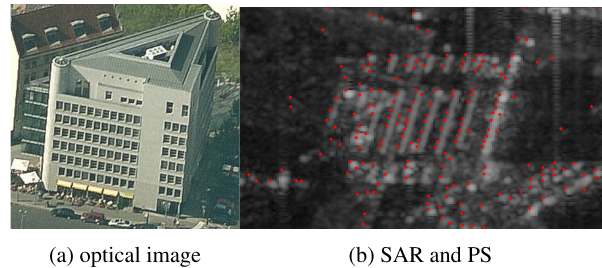
Figure 1: One facade in (a) an optical oblique image and (b) mean amplitude SAR image with overlayed Persistent Scatteres in red. The regular pattern of windows at the facade is perceivable in both data types.